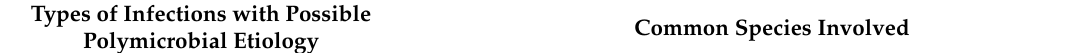
Table 1. Examples of infections with possible polymicrobial etiology and species involved. Types of Infections with